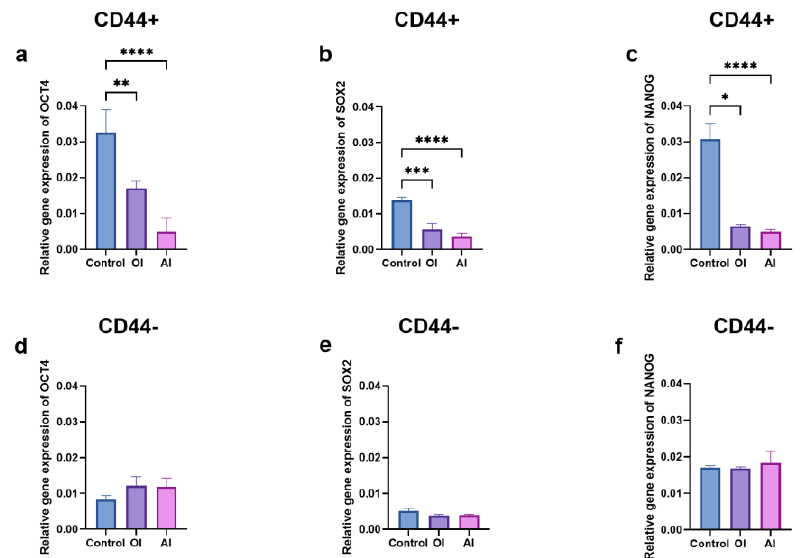
Figure 10. Relative gene expression levels of stemness markers in CD44 + and CD44 − cells after 21 days of osteo-induction (OI) and adipo-induction (AI). The expression of OCT4 ( a ), SOX2 ( b ), and NANOG ( c ) stem cell markers in CD44 + ; OCT4 ( d ), SOX2 ( e ), and NANOG ( f ) stem cell markers in CD44 − cells. CD44 + —CD44-positive cells, CD44 − —CD44-negative cells, * p ≤ 0.05, ** p ≤ 0.01, *** p ≤ 0.001, and **** p ≤ 0.0001.